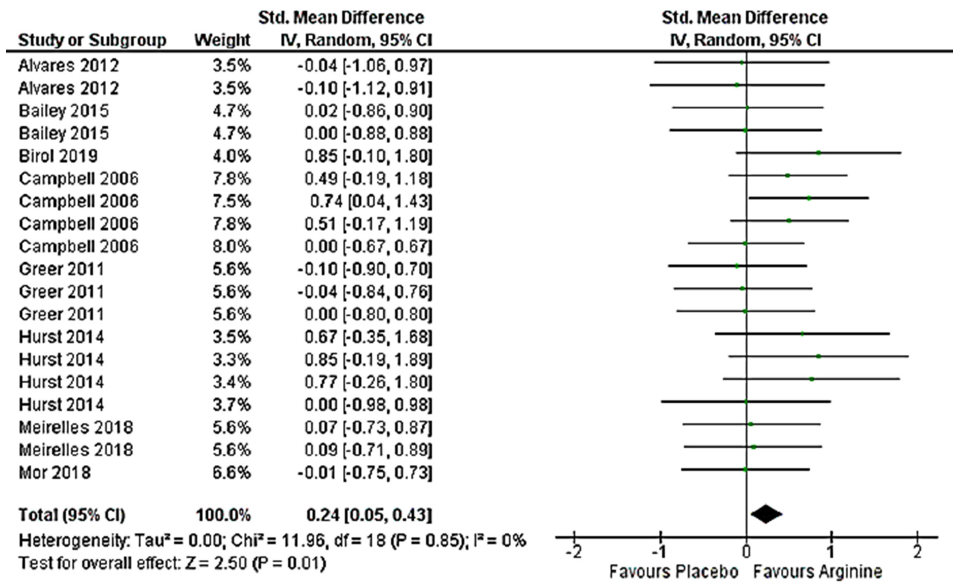
Figure 5. Forest plot comparing the effects of arginine supplementation on anaerobic (>VO 2 max) performance.